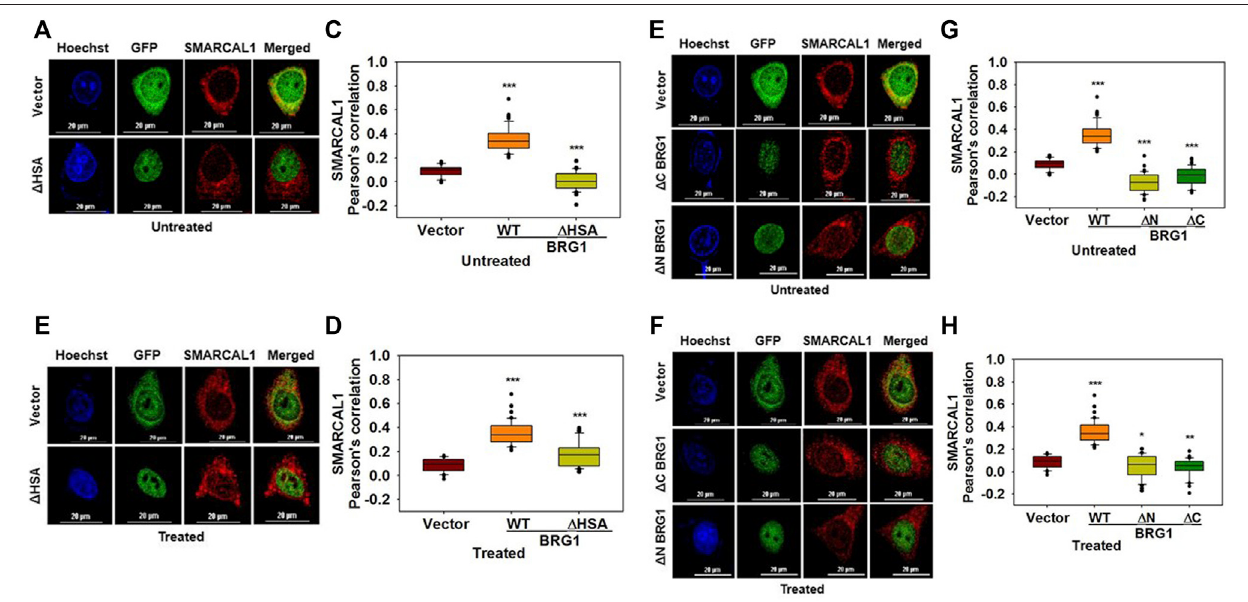
FIGURE5| MultipleregionsofBRG1arerequiredforinteractionwithSMARCAL1 (A) .Co-localizationofGFP- Δ HSAwithendogenousSMARCAL1intheabsence of doxorubicin treatment (B) Co-localization of GFP- Δ HSA with endogenous SMARCAL1 in the presence of doxorubicin treatment (C) . Pearson ’ s coef fi cient for the interaction of GFP- Δ HSA with endogenous SMARCAL1 in the absence of doxorubicin treatment (D) . Pearson ’ s coef fi cient for the interaction of GFP- Δ HSA with endogenous SMARCAL1 in the presence of doxorubicin treatment (E) . Co-localization of GFP- Δ N and GFP- Δ C with endogenous SMARCAL1 was monitored in the absence of doxorubicin treatment (F) . Co-localization of GFP- Δ N and GFP- Δ C with endogenous SMARCAL1 was monitored in the presence of doxorubicin treatment (G) . Pearson ’ s coef fi cient for the interaction of GFP- Δ N and GFP- Δ C with endogenous with SMARCAL1 in the absence of DNA damage (H) . Pearson ’ s coef fi cient for the interaction of GFP- Δ N and GFP- Δ C with endogenous with SMARCAL1 in the presence of DNA damage. In all these experiments, HeLa cells were treatedwith2 μ Mdoxorubicinfor10 minandn ≥ 40cellswereanalyzed.Starindicatessigni fi cancewith* p -value < 0.05,** p -value < 0.005,*** p value < 0.0001.Thewild- type data used in the analysis has been shown inFigure 2.The scale in the images is 20 μ m.